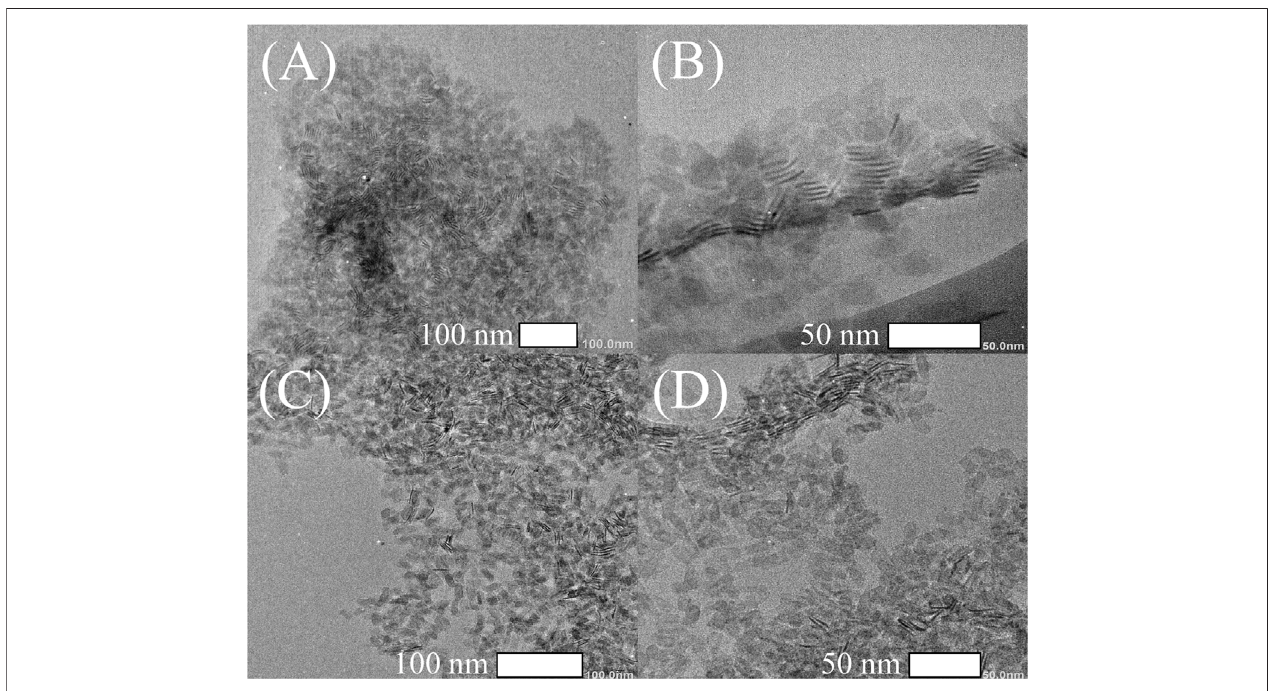
FIGURE 2 | TEM images of 4.5 ML CdSe NPLs capped with different ligands (A,B) RCOO-and (C,D) TEB.